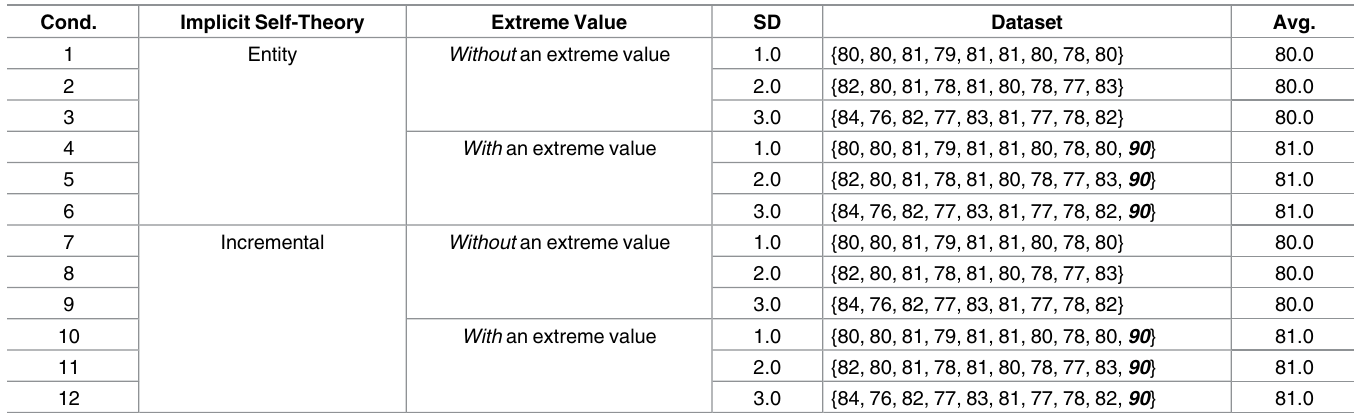
NOTE: The sample mean of every without-an-extreme-value condition remained the same (80.0). With-an-extreme-value conditions added a score of 90 to the datasets of corresponding without-an-extreme-value conditions. As a result, the SDs in the with-an-extreme-value conditions are slightly higher than those of the corresponding